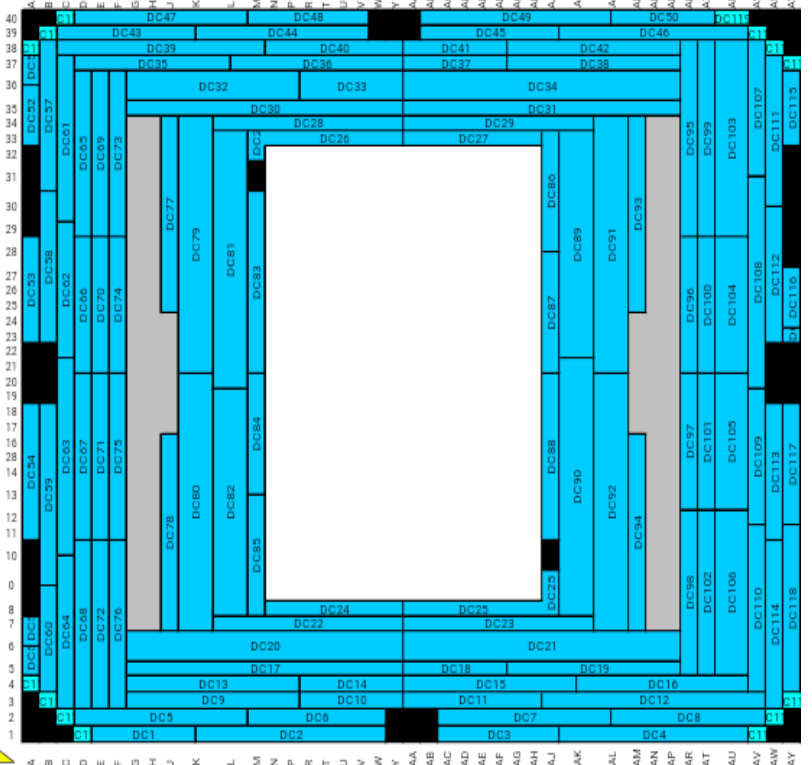
Figure 5. Schematic representation of daisy chain layout.